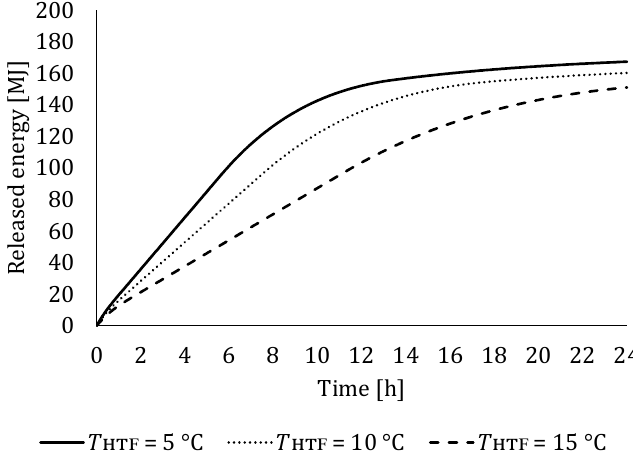
Figure 17. Comparison of released energy during solidification obtained numerically for different HTF inlet temperatures, HTF inlet flow rate 800 l/h and initial PCM temperature 35 °C.